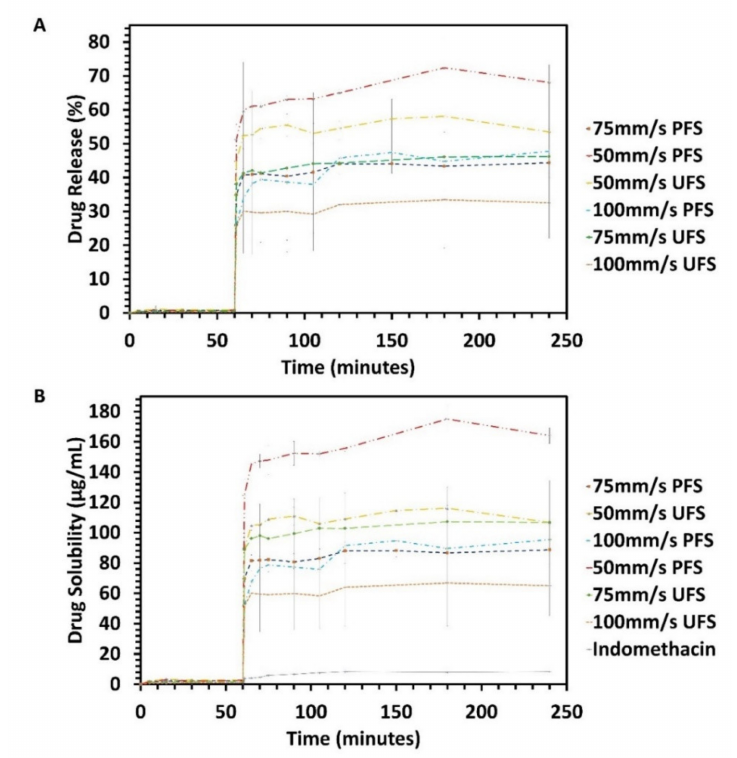
Figure 8. Non-sink, pH-shift in vitro performance testing of tablets printed at different laser speeds with PFS and UFS ( A ) Per-centage release of indomethacin from the 3D printed tablets ( B ) Solubility of indomethacin with different